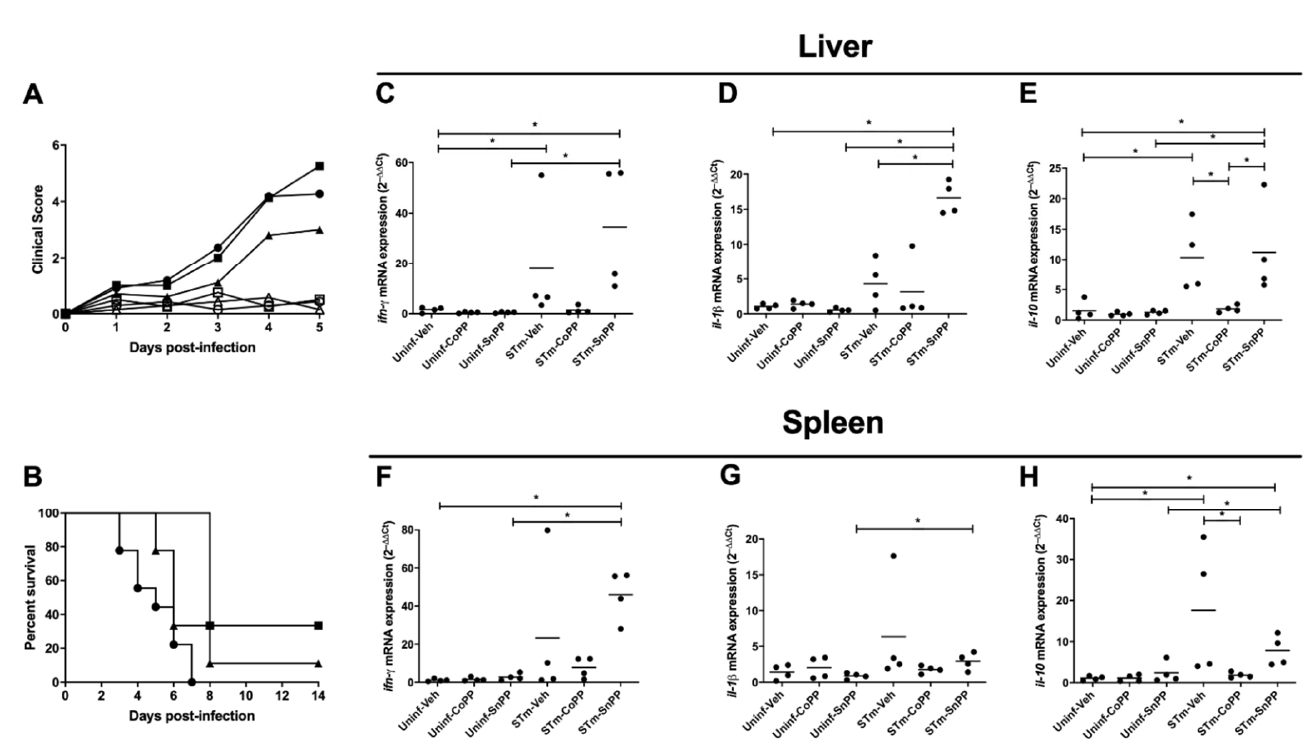
Figure 1. Hmox1 induction has no major effect on the clinical score and survival rates and has a mild anti-inflammatory effect in the acute model of S . Typhimurium infection in mice. Female C57BL/6 mice were treated with CoPP, SnPP, or vehicle (Veh) 24 h before intragastric infection with 1 × 10 6 CFU of S. Typhimurium (STm) or PBS as negative control (Uninf). ( A ) Clinical score was evaluated in infected and uninfected mice with all the treatments until day 5 post-infection or PBS administration (Uninf-Veh: white circles; Uninf-CoPP: white squares; Uninf-SnPP: white triangles; STm-Veh: black circles; STm-CoPP: black squares; STm-SnPP: black triangles ( B ) survival rates were evaluated daily until day 14 post-infection (STm-Veh n = 11; STm-CoPP n = 10; STm-SnPP n = 8; 3 independent experiments). No significant differences were observed between treatments. A 2-way ANOVA was used to compare differences between days in the same treatment. Mice were euthanized on day 5 post-infection and quantitative real-time PCR (qPCR) was performed to detect transcription of genes encoding IFN- γ , IL-1 β and IL-10 in the liver and spleen ( C – H ) (n = 4, 1 independent experiment). The Student’s t -test was used to evaluate differences, and results with statistically significant differences are shown (*: p < 0.05).